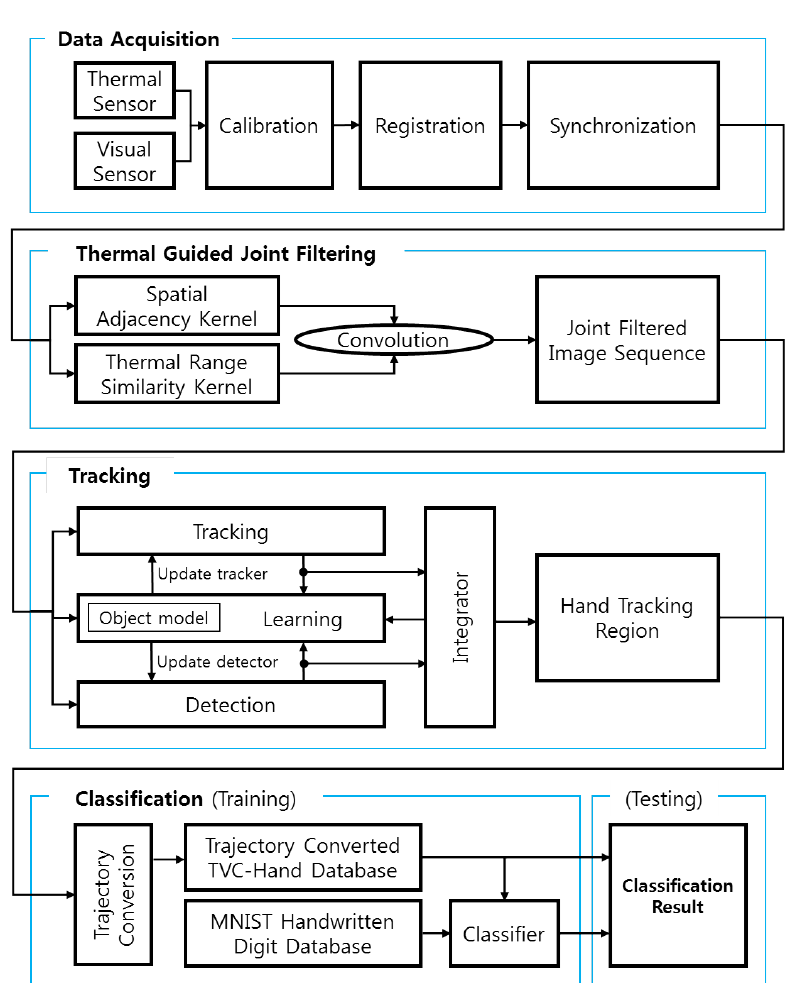
Figure 8. Overview of systematic